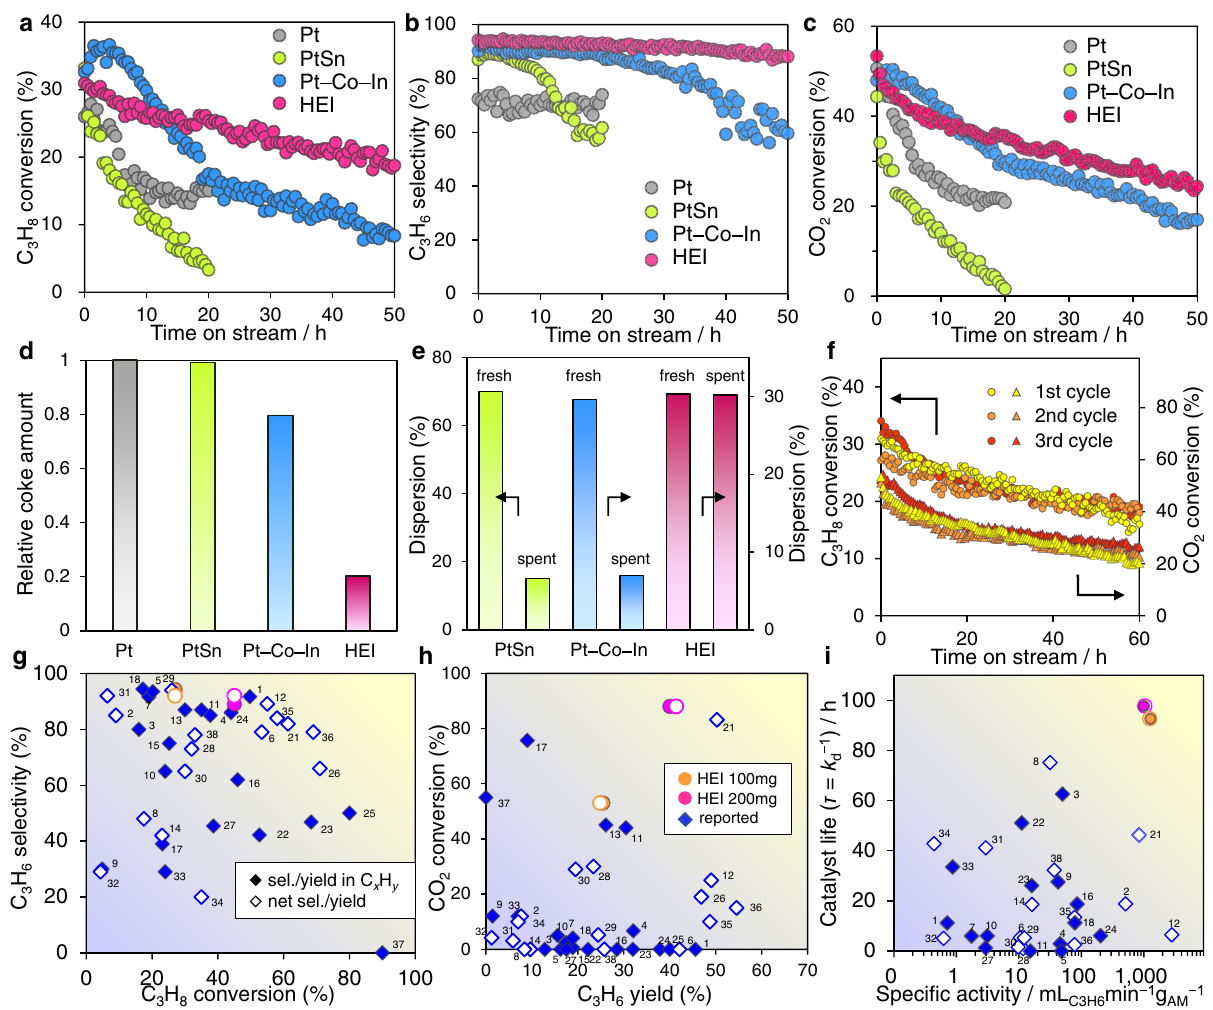
Fig. 3 | Catalytic performanceofHEI/CeO 2 in theCO 2 -ODP. Reaction conditions: catalyst amount, 100mg; gas feed, C 3 H 8 :CO 2 :He=5:5:10mL·min − 1 ; temperature, 600°C. a – c Time course of ( a ) C 3 H 8 conversion, ( b ) C 3 H 6 selectivity in hydro- carbons, and ( c ) CO 2 conversion. d Relative coke amount accumulated by O 2 -TPO of the spent catalysts after the time stream of a in CO 2 -ODP at 600°C. e Metal dispersions comparison of fresh and spent catalysts. f Reusability of HEI/CeO 2 in repeated long catalytic runs with regeneration procedure (CO 2 :He=5:10mLmin − 1